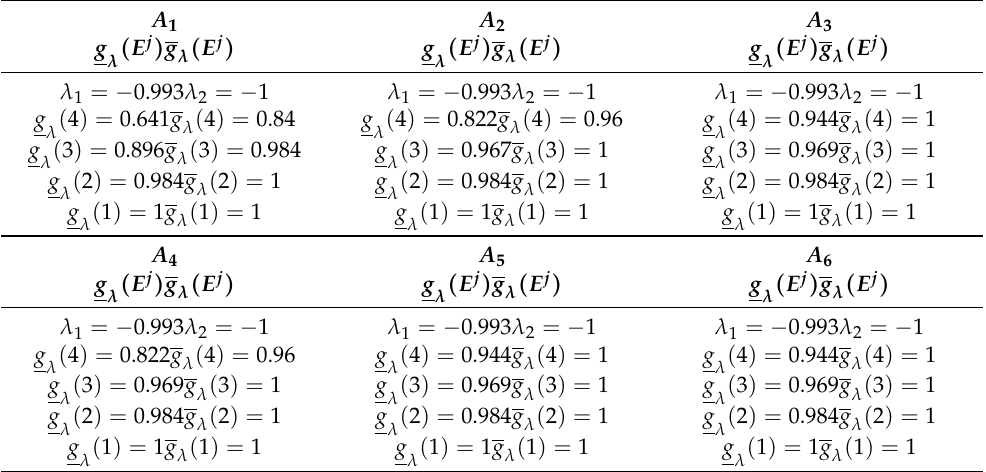
Table 7. The value of fuzzy measures on the primary criteria for α = 0 with respect to the cabi- net frame.